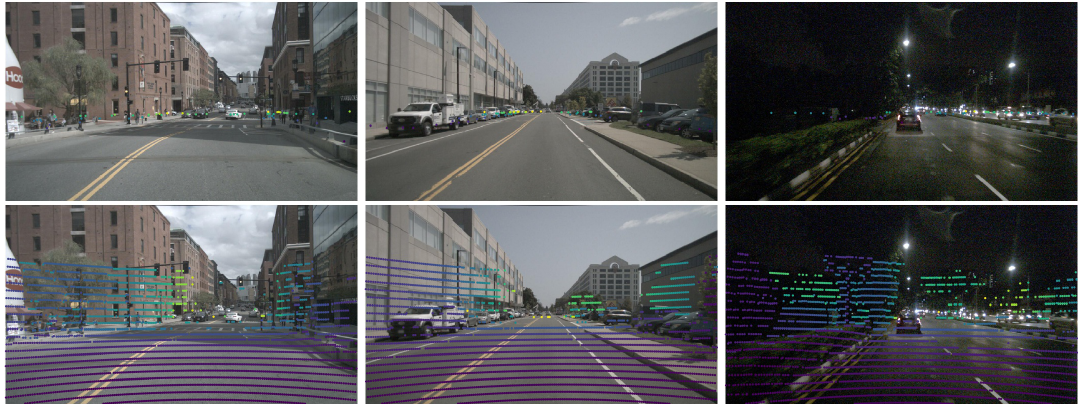
Figure 1. The rendering results in the camera coordinate about radar points (top row) and LiDAR points (bottom row). As shown in the figure, the return number of radar points is sparse compared with the LiDAR points. In addition, points in the camera coordinate with different colors represent different depth